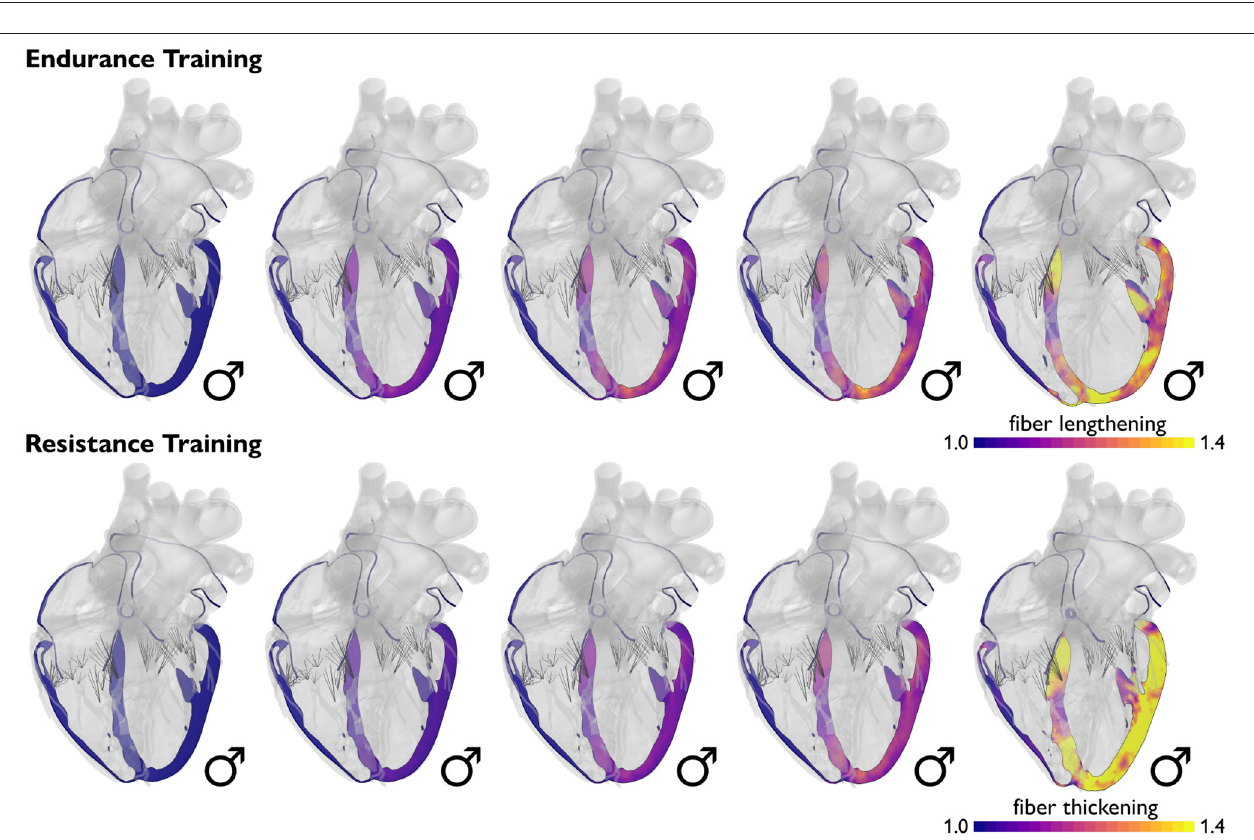
FIGURE 4 | Physiological adaptation to volume and pressure overload. Volume overload induced by endurance training causes primarily eccentric growth associated with ventricular dilation, while pressure overload induced by resistance training causes primarily concentric growth associated with ventricular wall thickening. Simulations allow us to probe the effects of endurance and resistance training on muscle fiber length and thickness and on the geometry of the heart as a whole. Blue colors indicate the baseline fiber length and thickness; yellow colors indicate a fiber lengthening and thickening of up to